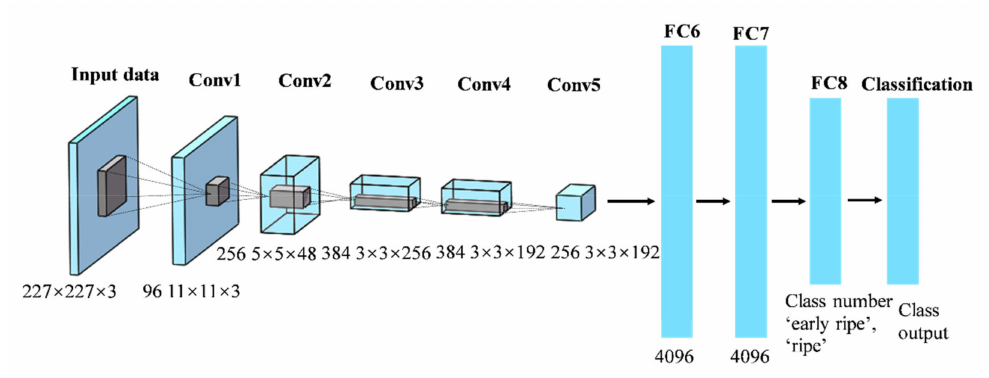
Figure 3. One typical CNN architecture for estimating the ripeness of strawberry based on hyperspectral imagery [34]. Note: Conv represents convolutional layer; FC: fully connected